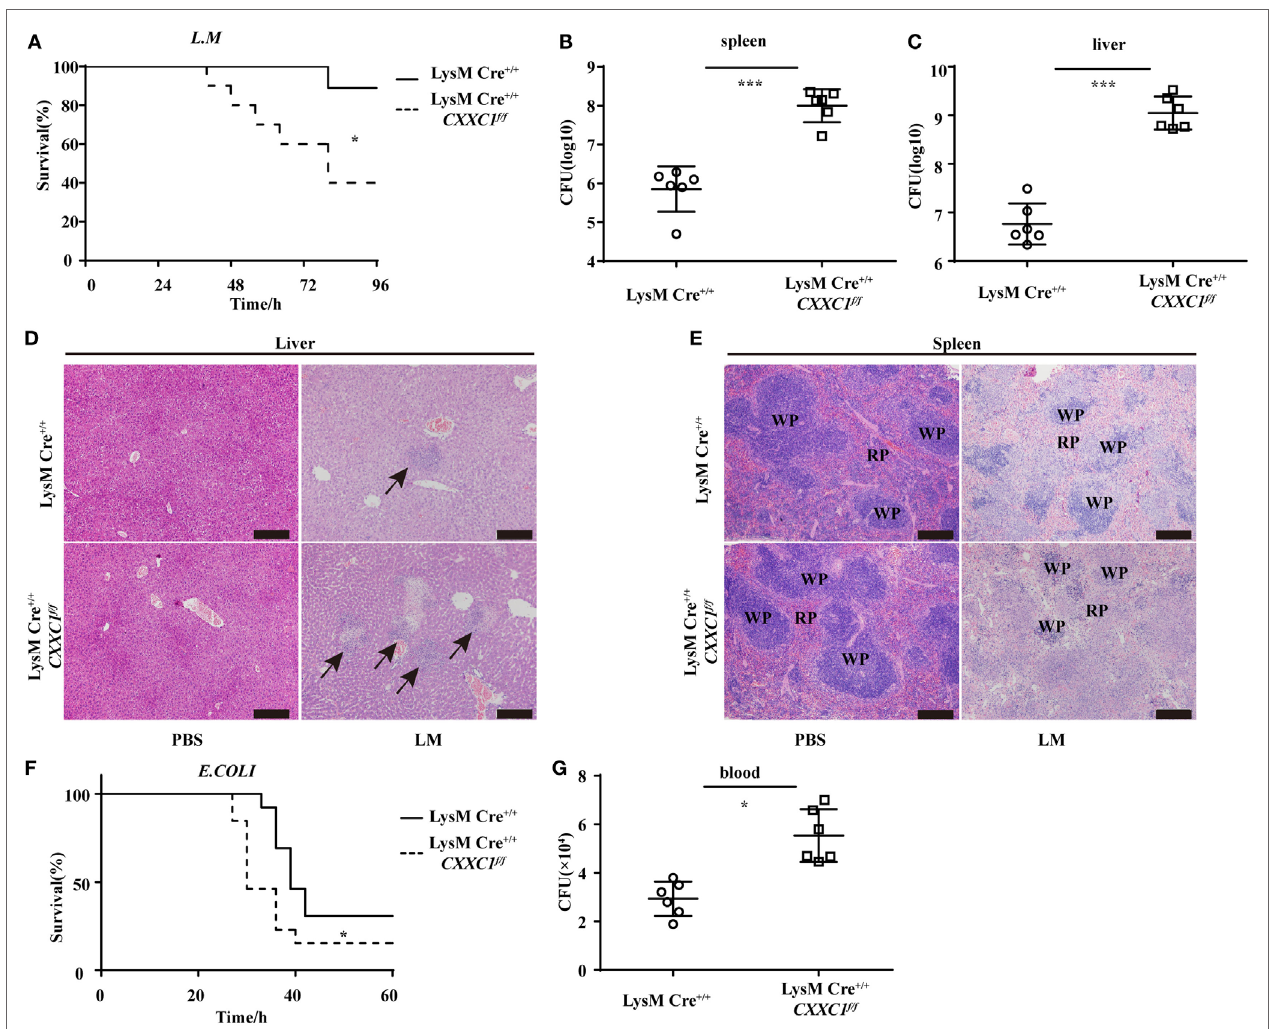
FigUre 2 | Cxxc finger protein 1 (CFP1)-deficient mice were more susceptible to Listeria monocytogenes and E. coli infection. (a) Survival of wild-type ( n = 10) and CFP1-deficient ( n = 11) mice injected in the tail vein with 5 × 10 5 L. monocytogenes and monitored every hour after infection. (B,c) Bacterial load in the spleen (B) or liver (c) of wild-type (white circle) and CFP1-deficient (white square) mice injected in the tail vein with 1 × 10 5 L. monocytogenes assessed on day 2 after infection ( n = 6 mice per genotype). (D,e) Hematoxylin and eosin staining of liver (D) and spleen (e) tissue from wild-type and CFP1-deficient mice 48 h after tail vein injection of 1 × 10 5 L. monocytogenes . The scale bars represent 200 µm. (F) Survival of wild-type and CFP1-deficient mice ( n = 13) injected intraperitoneally with 3 × 10 8 E. coli and monitored every hour after infection. (g) Bacterial load in blood (10 µl) collected 24 h of wild-type (white circle) and CFP1-deficient (white square) mice after infection as in (F) . CFU, colony-forming units ( n = 6 mice per genotype). Each symbol represents an individual mouse; the small horizontal lines indicate the mean (B,c,g) . * P < 0.05 and *** P < 0.001 indicate significant differences between groups as determined by Student’s t